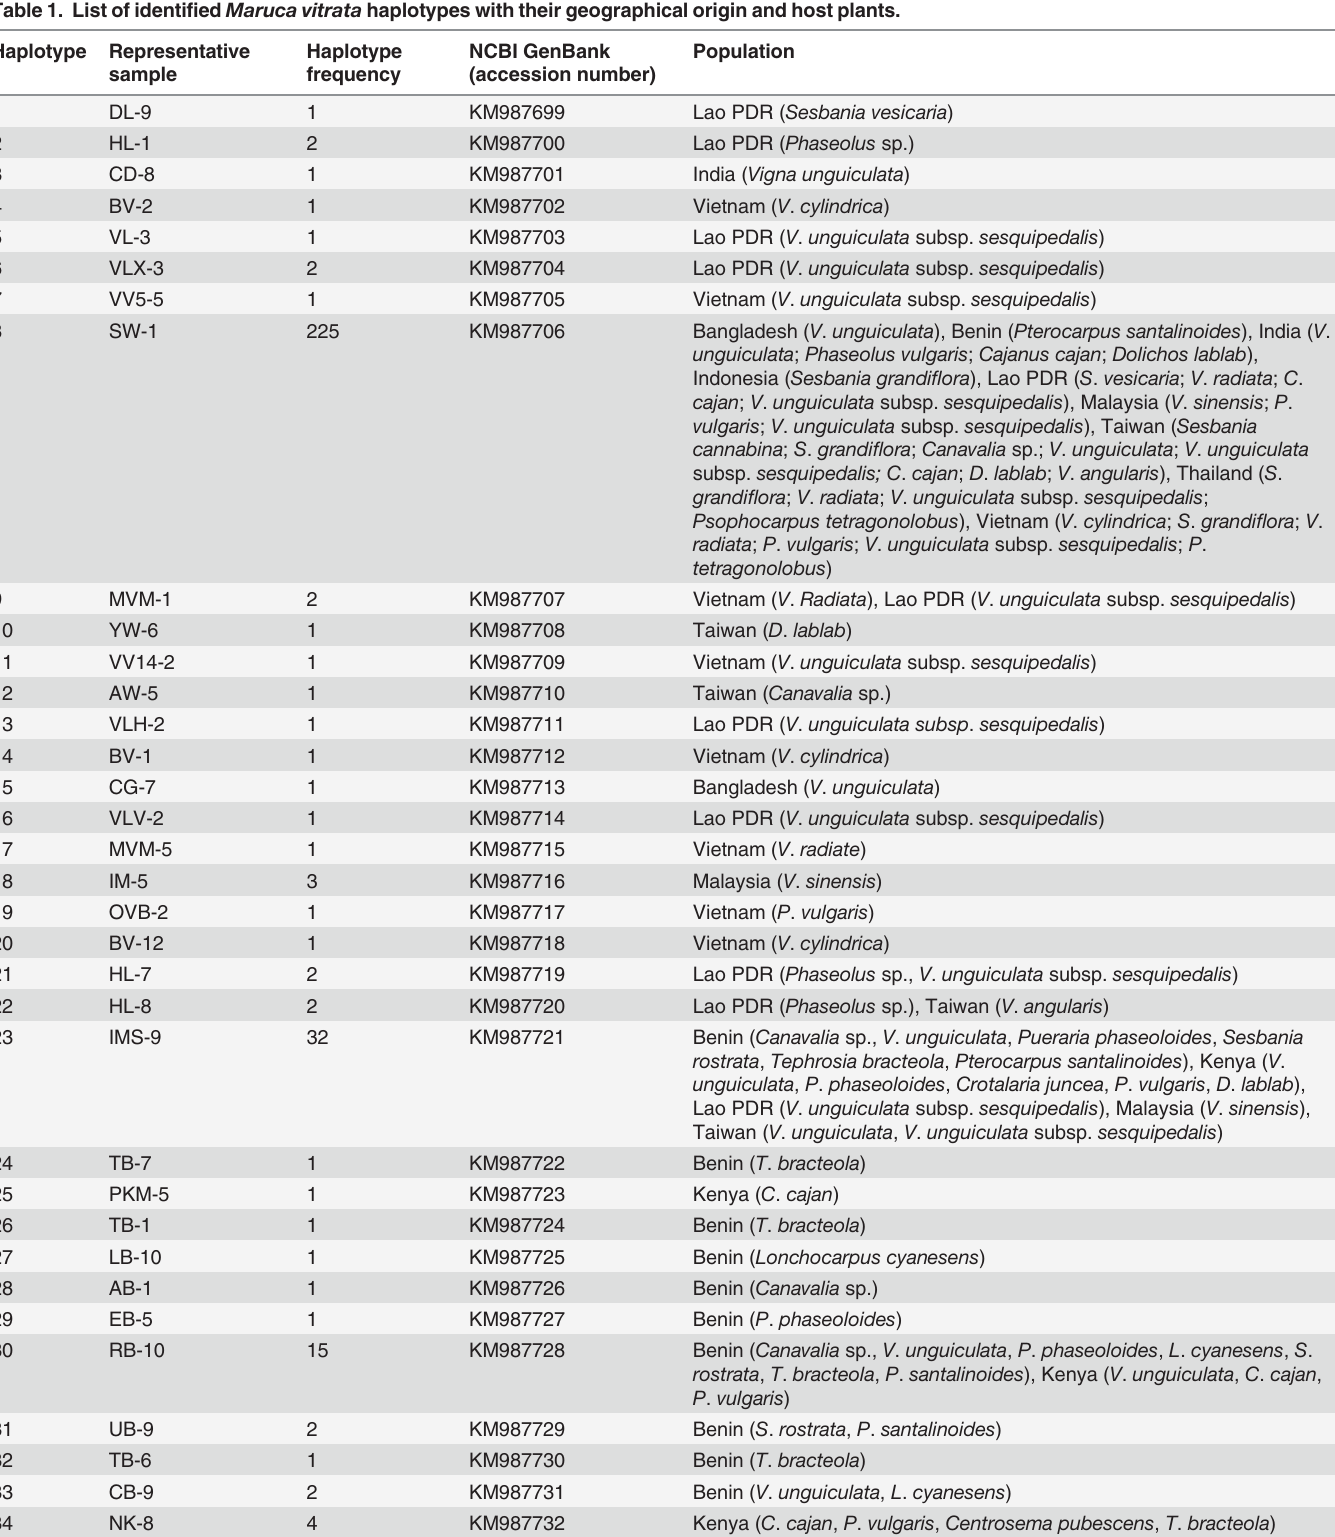
Table 1. List of identified Maruca vitrata haplotypes with their geographical origin and host